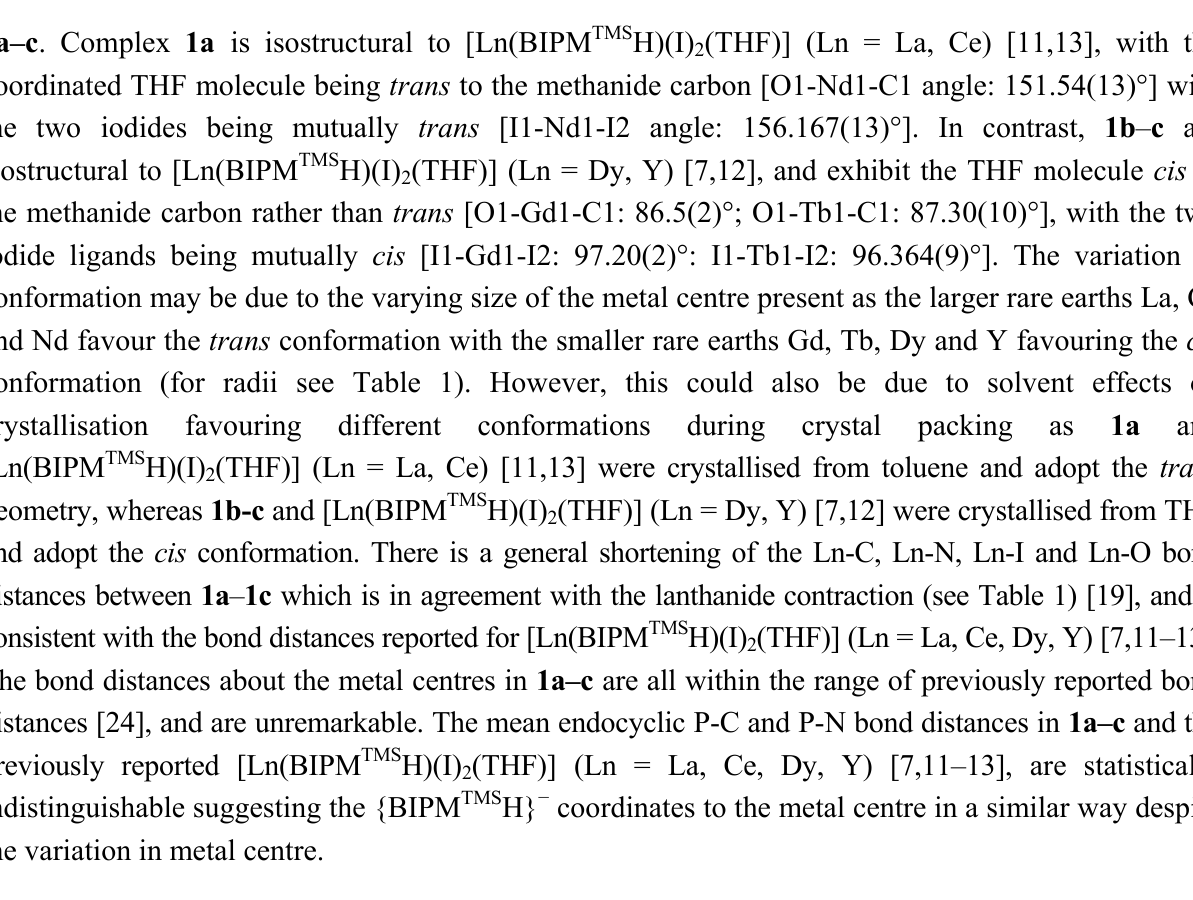
H with selected atom labelling. Displacement 7 8